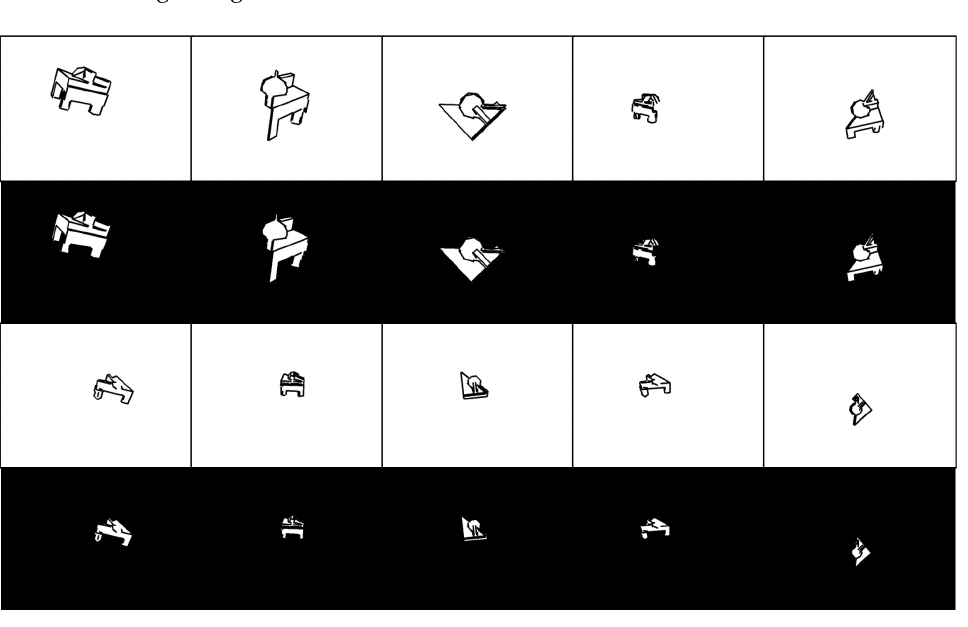
Figure 4. Physical dataset. ( a ) An example of the image. The 3D-printed object is placed on the AR marker. ( b ) The distribution of camera position. An object is placed on the origin of the coordinate. After capturing images of the object, LSD [22] is adapted and line segments are displayed on the image. We used the default value of OpenCV implementation for the LSD parameter. The thickness of displayed line segments is two ways: 1 and 2. We matched the condition of thickness between training and inference images. Figure 5 shows examples of RGB-based edge images.